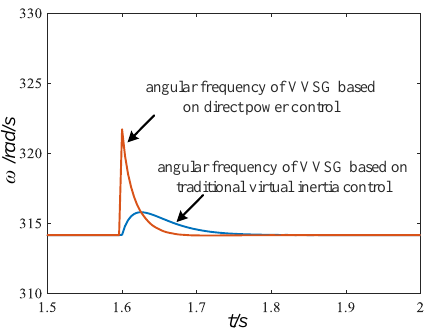
Figure 12. The angular frequency waveforms of VVSG connected to a strong utility grid. Case 2: The conventional VVSG and the VVSG with a direct power control algorithm are connected to a utility grid at 1.5 s separately. At 1.6 s, the active power command increases from 0 kW to 60 kW, and from 2.0 s the grid frequency deviates 0.2%, the wave- forms of VVSG output active power are shown in Figure 13. As the grid frequency de- creases, the steady-state output active power increases by 20kW. In addition, the active power response of conventional VVSG and VVSG with a direct power control algorithm to grid frequency deviation are the same, indicating that direct power control only affects